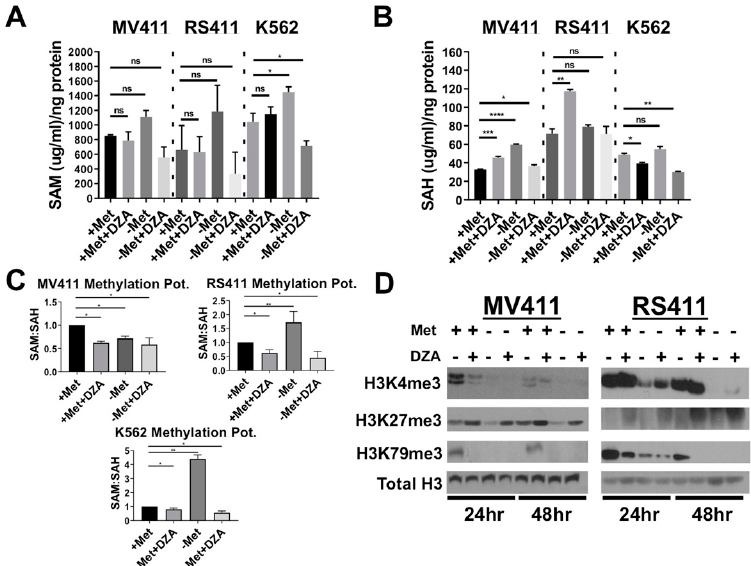
Figure 2. Disruption of Met/SAM metabolism increases intracellular SAH concentration and decreases overall methylation potential. (A) From left to right; Intracellular SAM concentration was not significantly changed in either MV411 or RS411 cells but was significantly elevated in K562 cells upon methionine starvation and significantly reduced with DZA treatment and methionine deprivation (Tukey HSD, * = p < 0.05). (B) From left to right; Intracellular SAH concentration was increased in MV411 cells under all experimental conditions and timepoints, while only DZA-mediated inhibition of SAH metabolism sufficiently increased intracellular SAH concentration in RS411 cells (Tukey